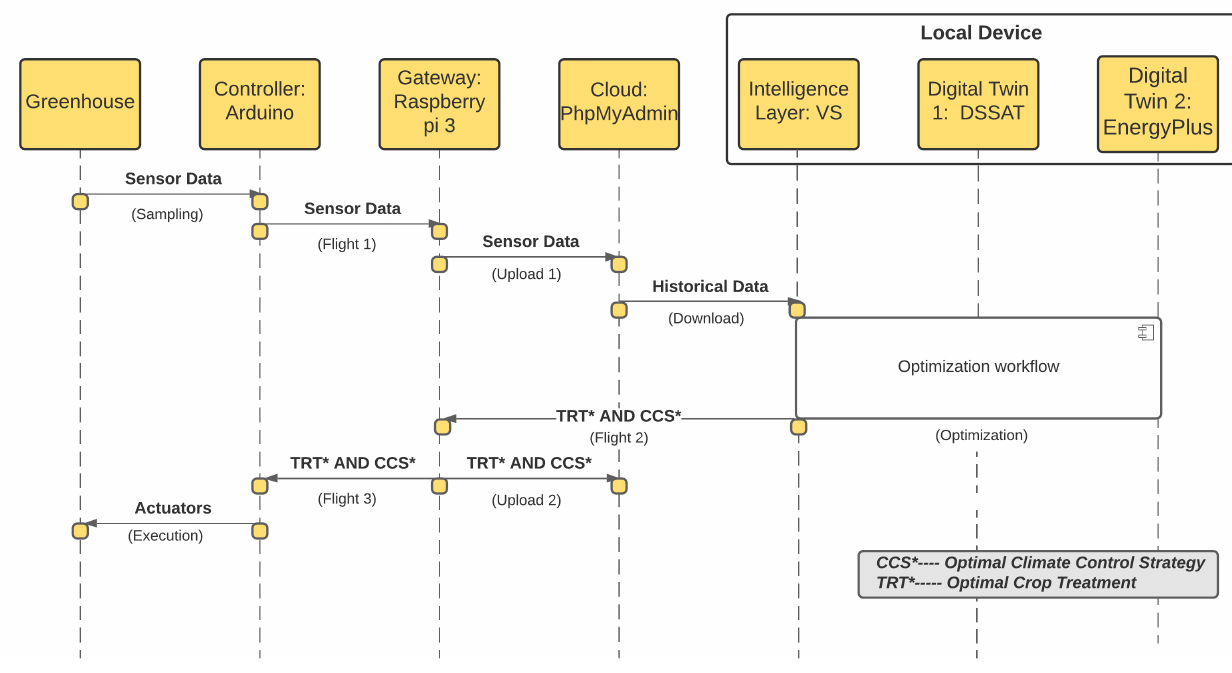
Figure 6. Sequence diagram showing the communications between the actors of the DT architecture. The name of each communication is indicated in